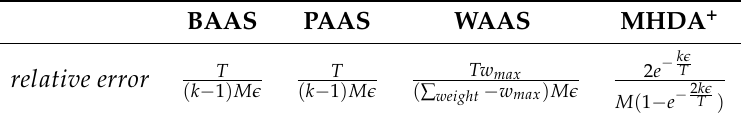
Table 7. Comparison of the relative